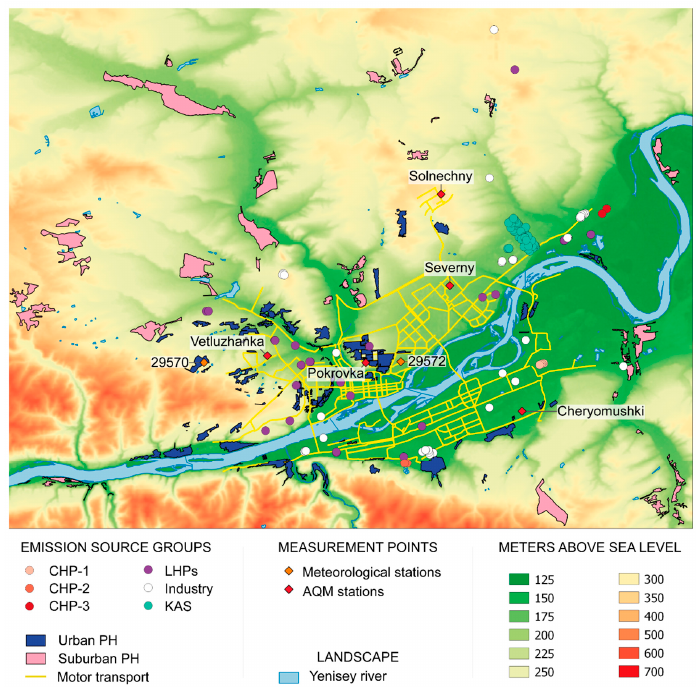
Figure 2. A heterogeneous landscape of the Krasnoyarsk greater area. Spatial distribution of the main emission sources, meteorological stations, and observation points (air quality measuring stations, AQM).